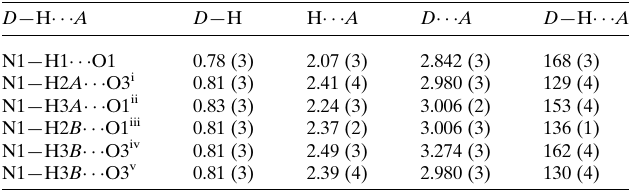
Table 2 Hydrogen-bond geometry (A˚ , (cid:6) ).